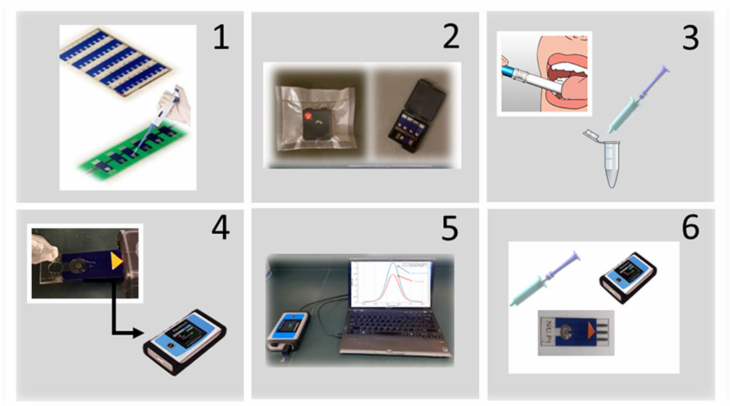
Figure 4. ( 1 ) Demonstrating sensors before cutting and fabrication, and sensors are separated and fixed on a tray during fabrication. ( 2 ) Demonstrating sensors’ storage gel box and how they are vacuum-packed during storage. ( 3 ) Insert the absorbent pad into the mouth and masticate for ~30 s. Insert the wetted absorbent pad into the syringe barrel, and squeeze the absorbent pad using the plunger. ( 4 ) Test setup; a portable potentiostat connected to a laptop to perform the electrochemical tests. ( 5 ) Positive/negative results, and the viral load will be shown on the screen. ( 6 ) An overview of the whole testing